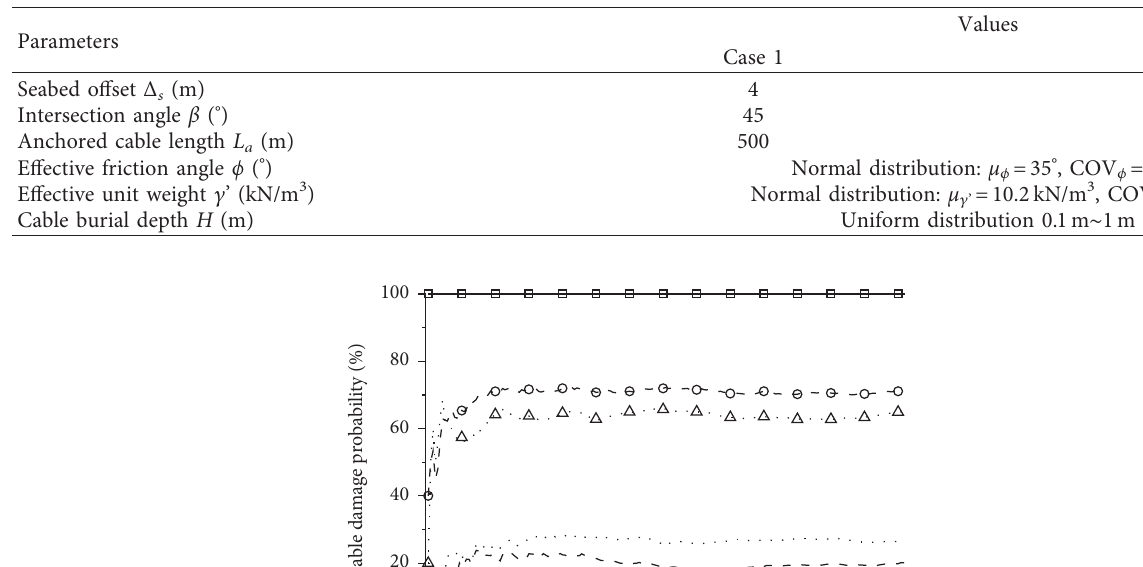
Table 2: Parameters for investigating the effect of correlation length.